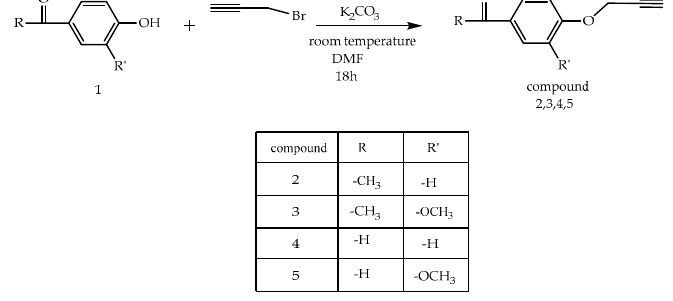
Scheme 1. Cont . Scheme 1.